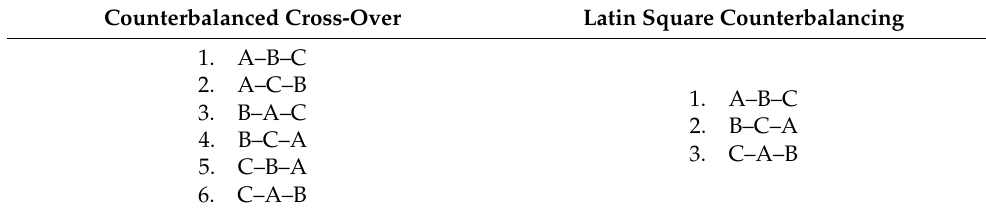
Table 3. Example of counterbalancing for 3! conditions. Counterbalanced